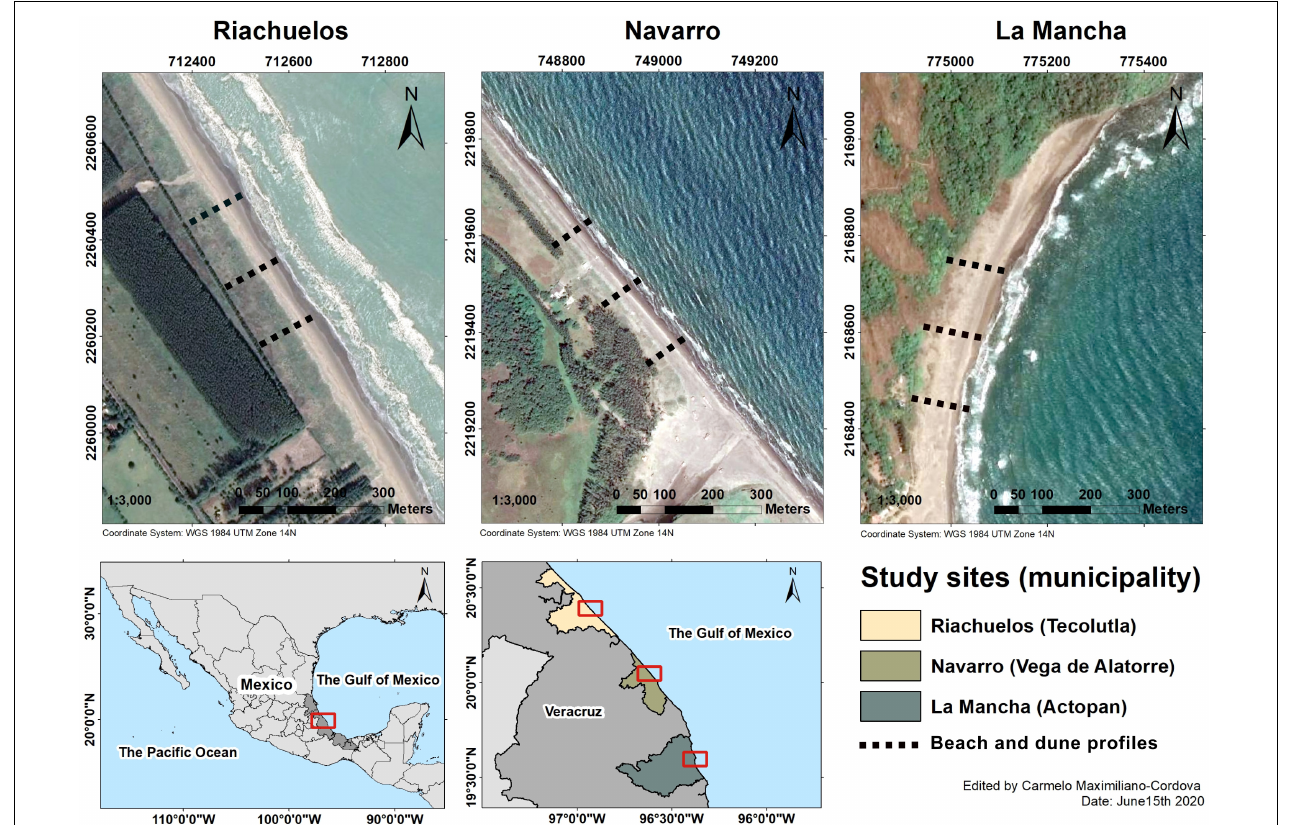
FIGURE 1 | Location of the study sites in the state of Veracruz, Mexico. Images based on satellite images from Google Earth.